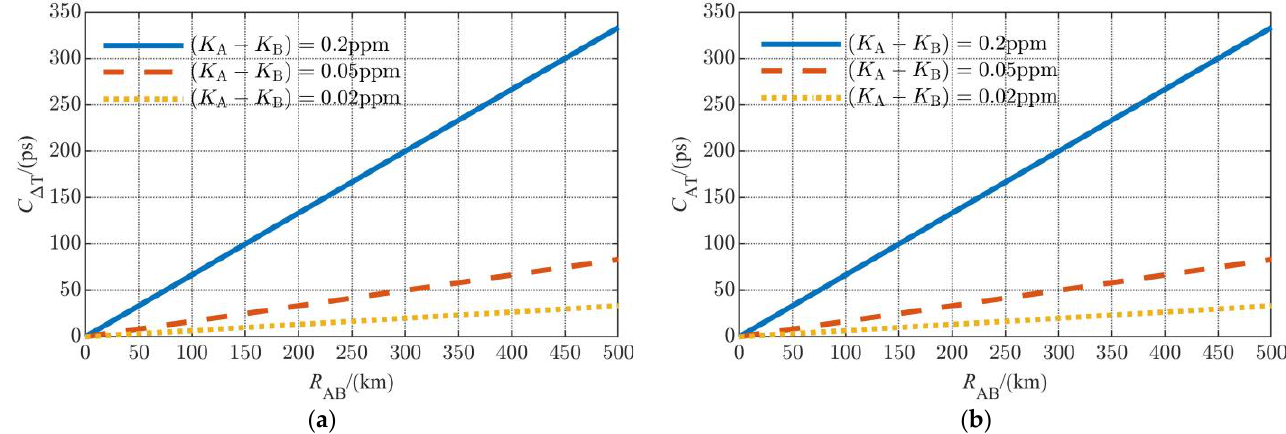
Figure 2. Numerical results of the error caused by frequency deviation: ( a ) time difference measure- ment error; ( b ) range measurement error (normalized to time).